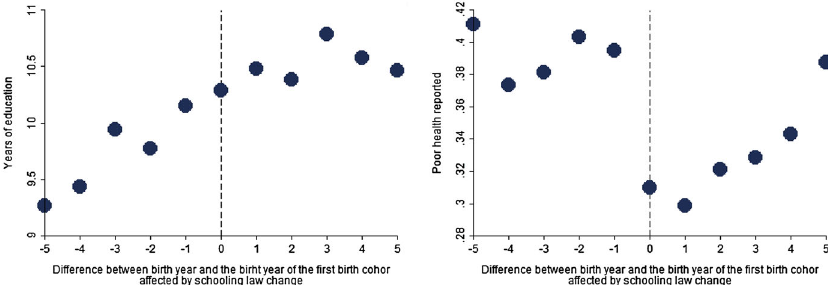
Fig. 1 Adjusted proportion of years of education (left) and reporting poor health (right) by birth cohorts. Average proportion of reporting poor health is based a probit regression of self-reported poor health against gender, birth cohort dummies, country dummies. The sample includes individuals born 5 years before and after the birth cohort affected by schooling law change. Data source: HRS wave 10, ELSA wave 3,